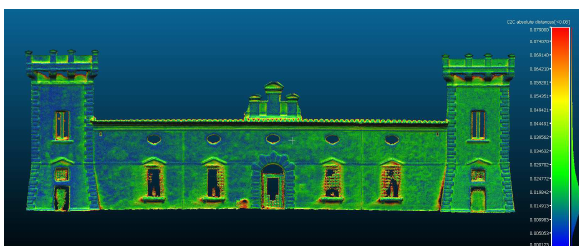
Figure 16: Weibull distribution of absolute distances between the photogrammetric point clouds and the TLS one. Project made from undistorted photos.